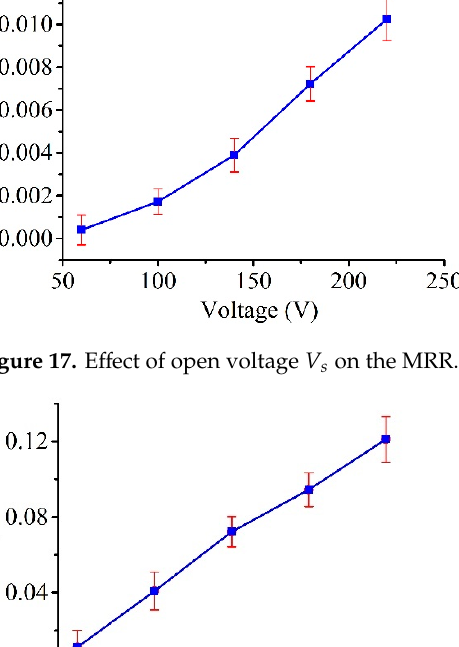
Figure 16. E ff ect of voltage V s on the line widths. Figure 16. Effect of voltage V s on the line widths.